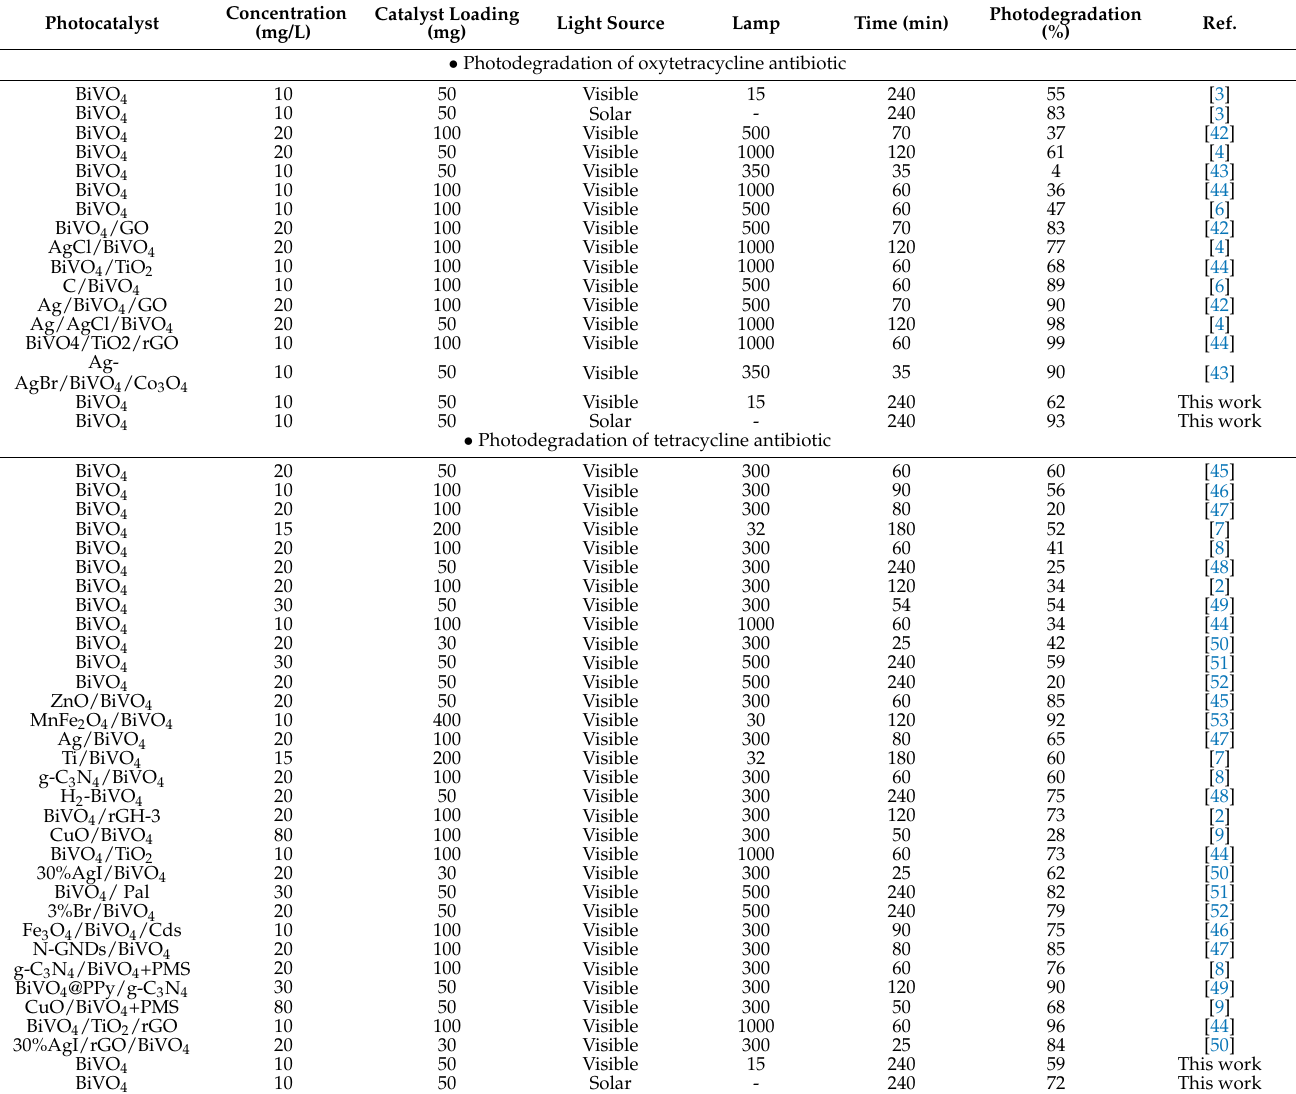
Table 1. Comparison of oxytetracycline and tetracycline antibiotic degradation via the use of various